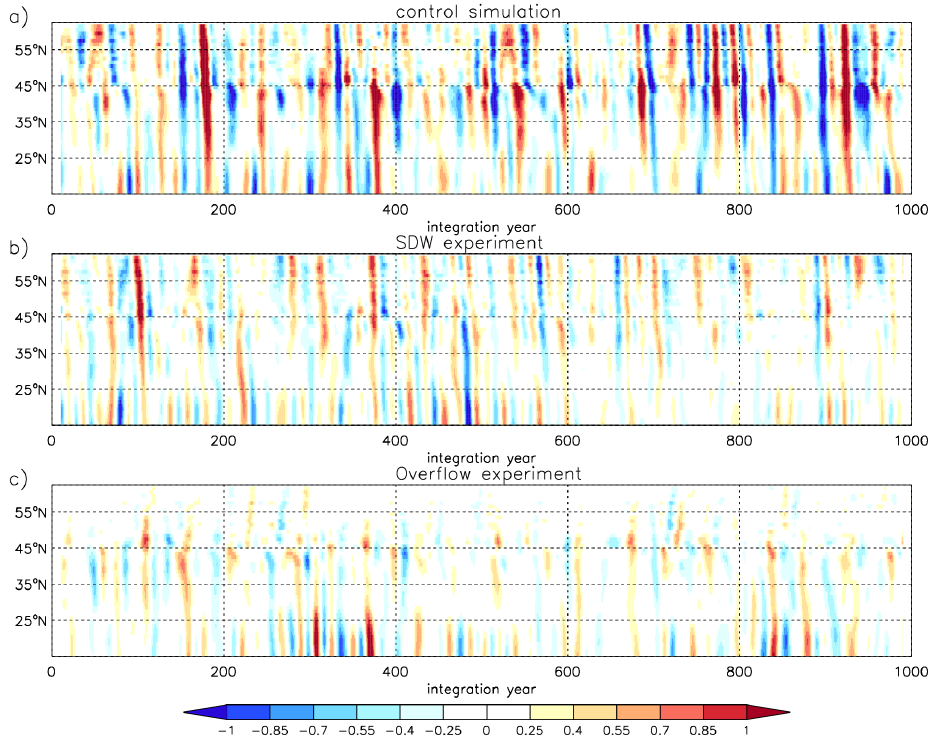
Fig. 8. Anomalous bandpass-filtered (15–80 years) maximum Atlantic meridional overturning streamfunction (in Sv) at different latitudes in the North Atlantic (depth level 1020m) in (a) the control simulation, (b) the SDW experiment and (c) the overflow experiment with